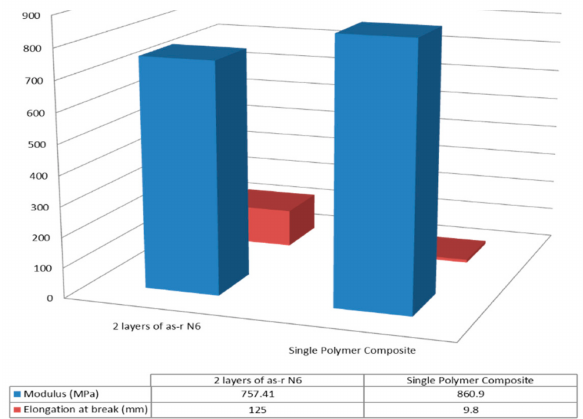
Figure 13. Moduli and elongation at break of asr- and nuc-nylon-6 films, where the latter film contained 2 wt% c-Nylon-6 and 98 wt% asr-nylon-6 obtained with permission from [44,45]. Copyright 2010, Elsevier Ltd and 2011, American Chemical Society.